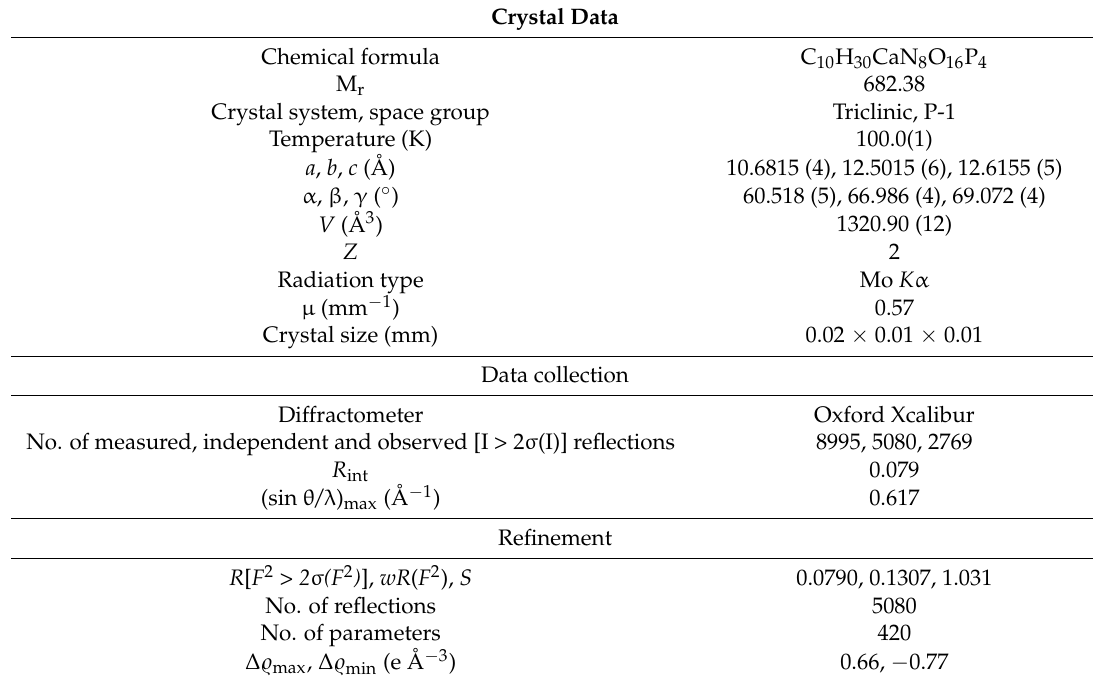
Table 3. X-ray crystallography experimental